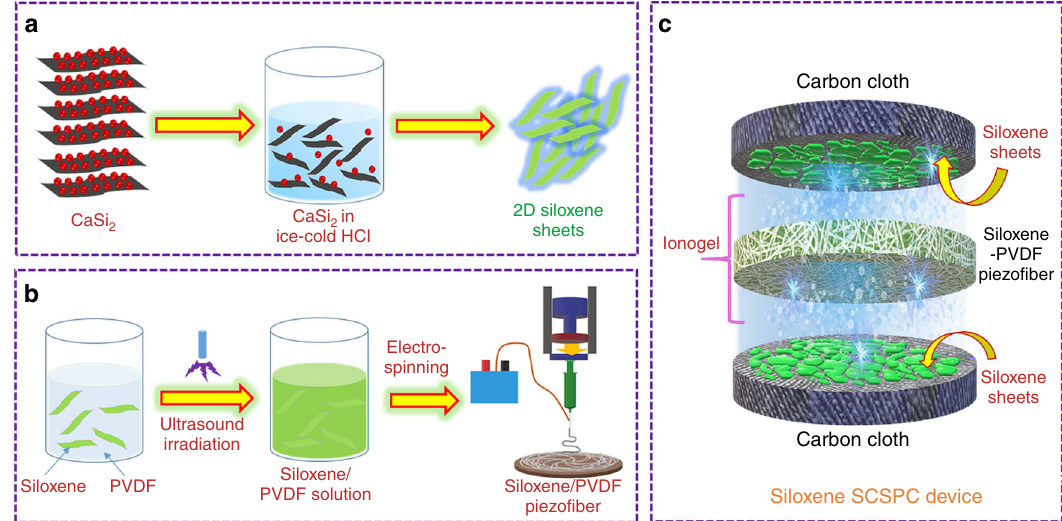
Fig. 1 Schematic representation of steps involved in the fabrication of siloxene SCSPC. a represents the preparation of siloxene sheets via topochemical deintercalation of calcium from CaSi 2 in the presence of ice-cold HCl solution, b represents the fabrication process involved in the electrospinning of siloxene/PVDF piezo fi bers, and c indicates the fabrication of a siloxene SCSPC device using siloxene sheets-coated carbon cloth as two symmetric electrodes and electrospun siloxene – PVDF piezo fi bers impregnated with ionogel electrolyte as the separator.